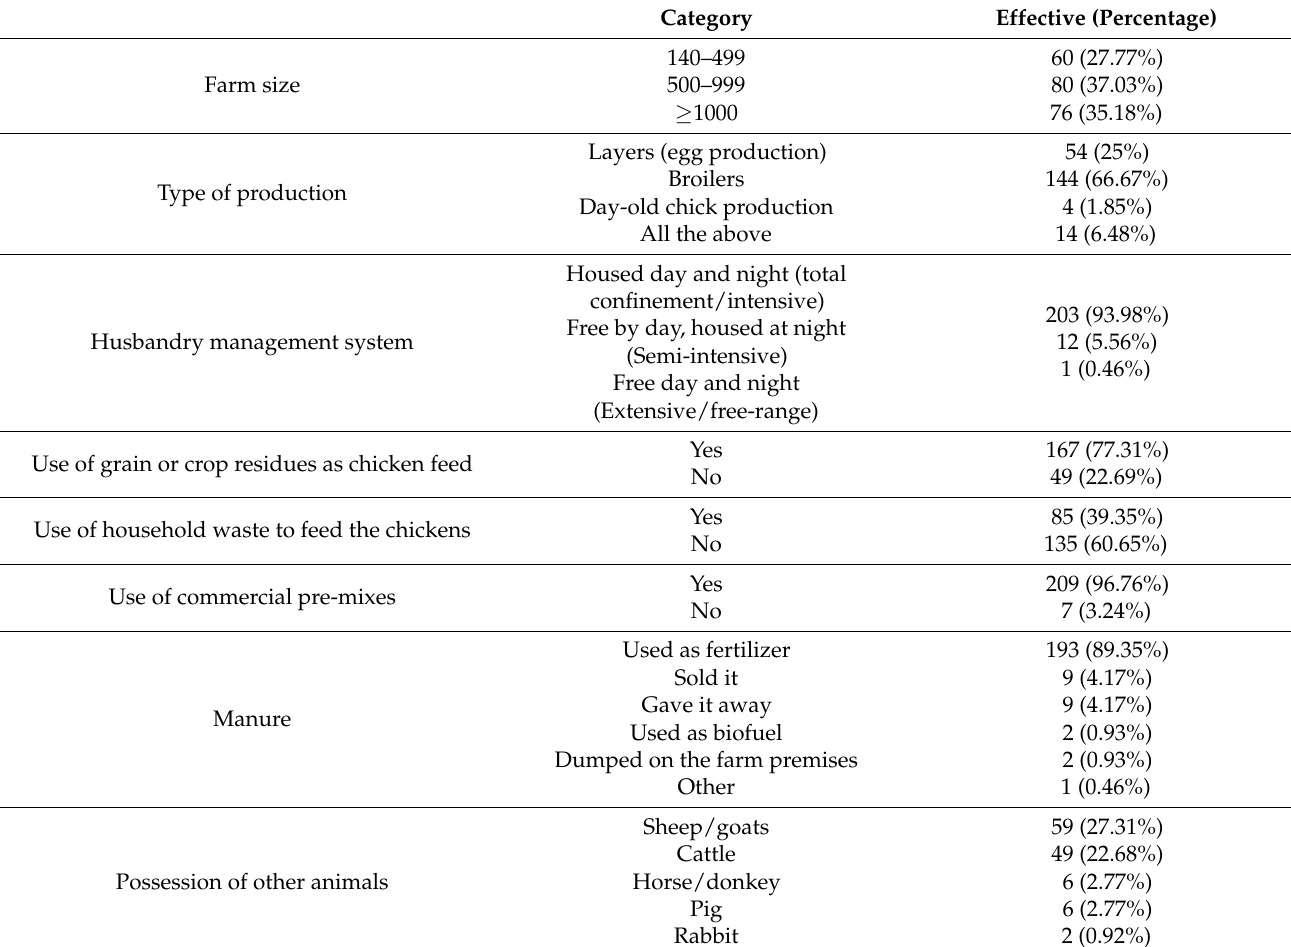
Table 2. Main characteristics of farms